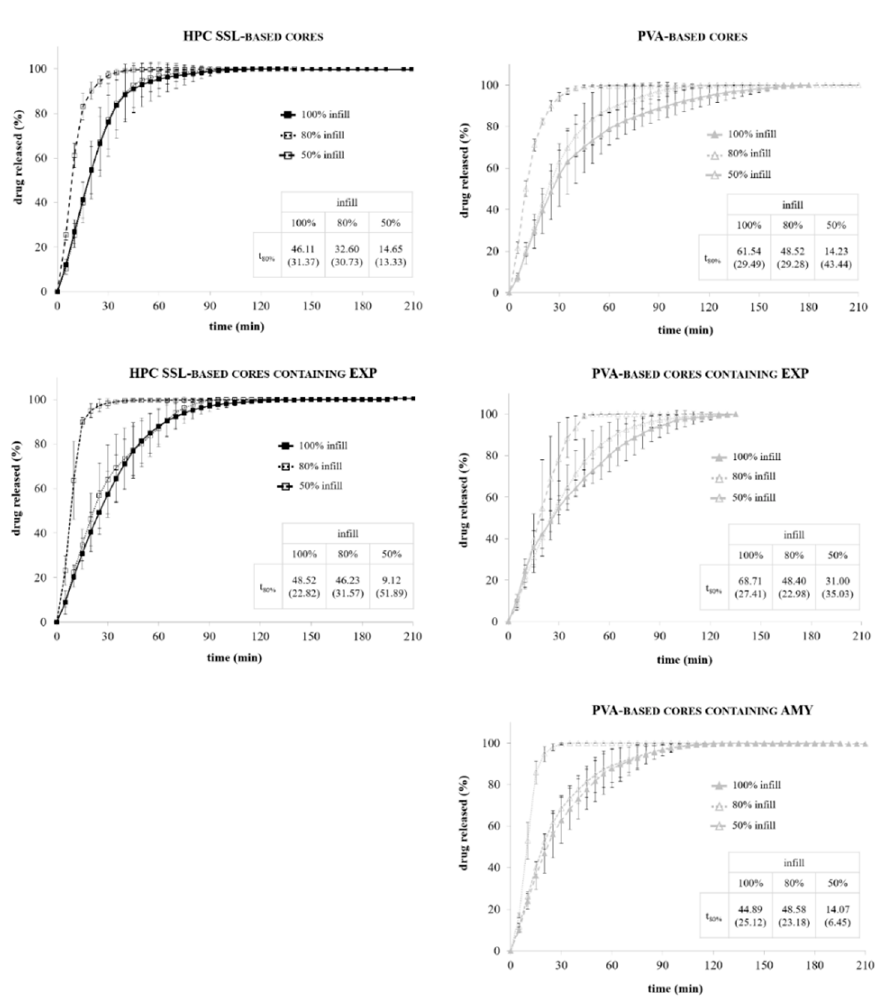
Figure 5. Release profiles of HPC SSL- and PVA-based cores (average release parameters and relevant CV, in brackets, are listed in boxes).